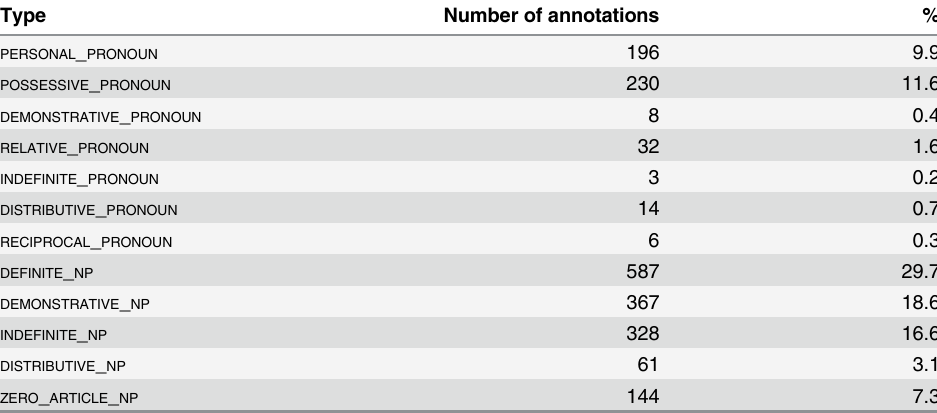
Table 3. Fine-grained coreferential mention counts.